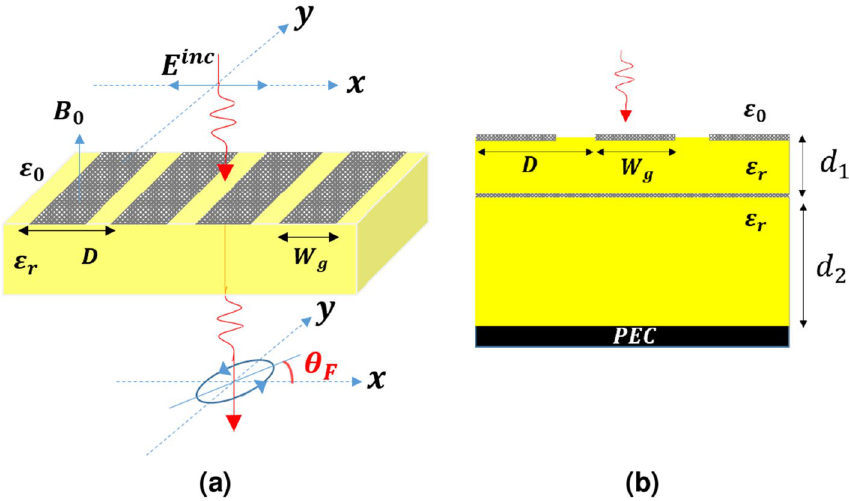
Figure 7. The schematic of ( a ) a PAMGS under illumination of x -directed wave at normal incidence. θ F is the Faraday rotation angle, ( b ) The tunable THz absorber made of a multilayer